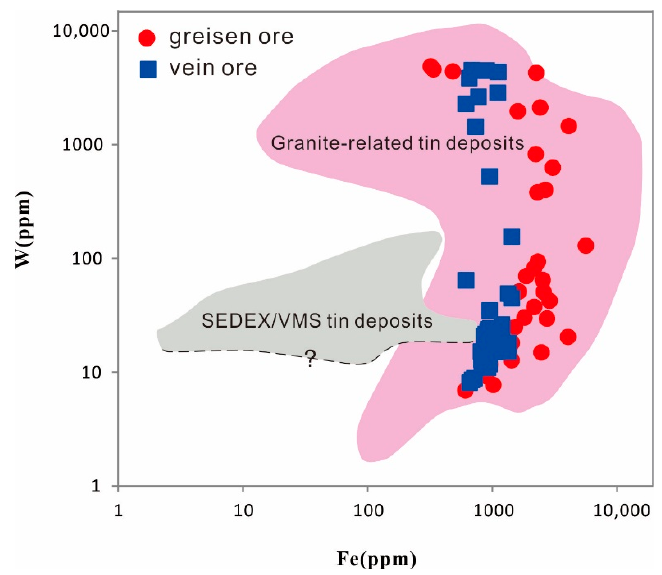
Figure 11. Binary plot of Fe versus W contents in cassiterite from the Maoping W–Sn deposit (modified from [70,71]).